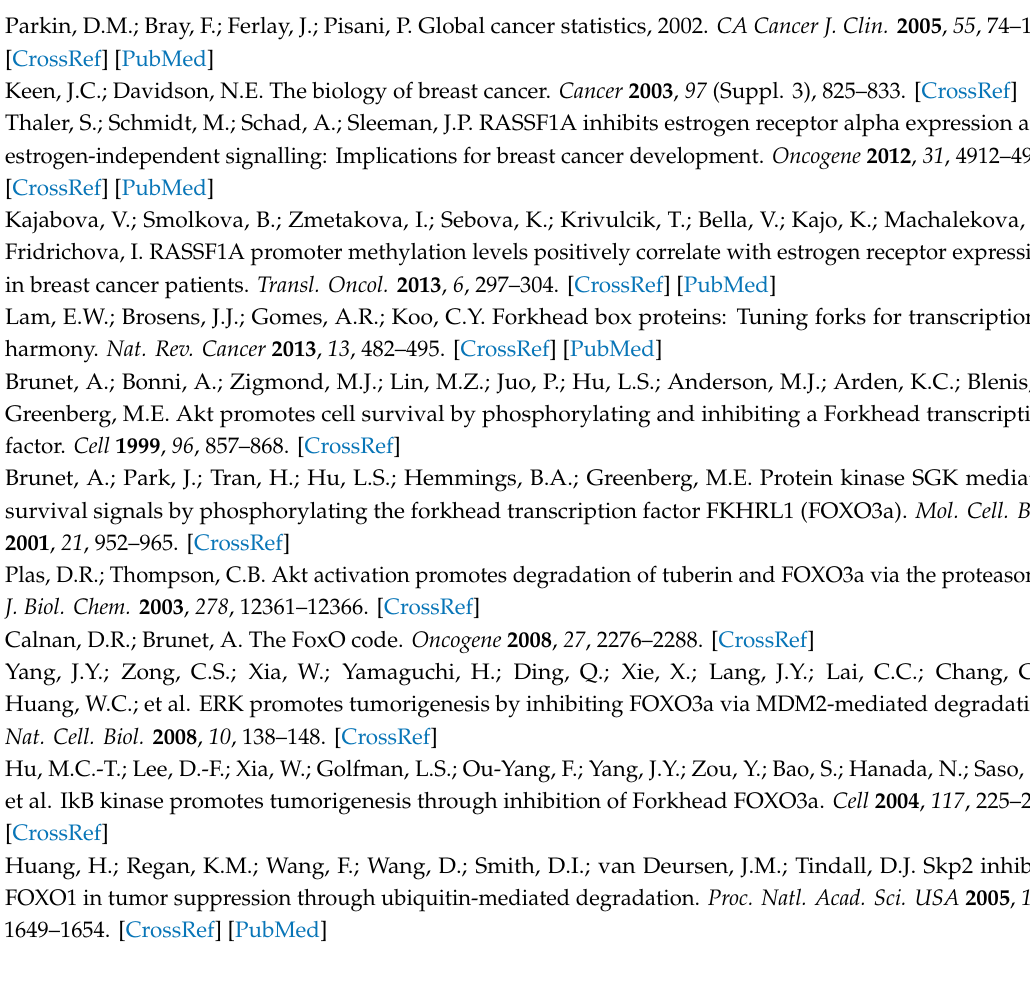
Figure S1: RASSF1A causes decreased expression of FOXM1 and ER α , and induces senescence, Figure S2: Knockdown of FOXM1 inhibits expression of ER α and induces cell cycle arrest and senescence, phenocopying the e ff ects of RASSF1A, Figure S3: Ectopic expression of FOXM1 cannot rescue RASSF1A-mediated ER α suppression and cell cycle arrest, Figure S4: FOXO3A is required for RASSF1A-mediated growth arrest and senescence, Figure S5: RASSF1A increases FOXO3A transcriptional activity through the suppression of AKT-mediated inhibitory phosphorylation and increased expression of FOXO3A, Figure S6: RASSF1A and FOXO3A cause decreased ER α and ER β activity, Figure S7: RASSF1A inhibits YAP1, and knockdown of YAP1 suppresses AKT1 activity, inhibits expression of ER α and FOXM1, and increases levels of